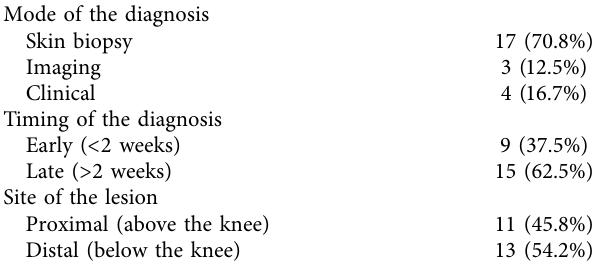
Table 2: The mode, the timing of the diagnosis, and site of the lesions.